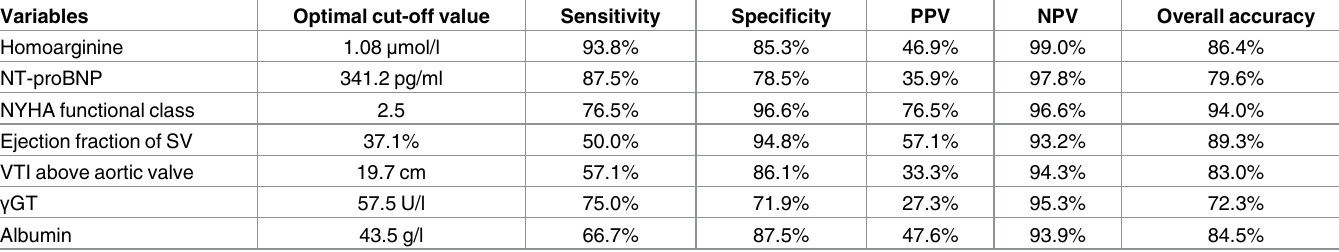
Table 3. Comparison of different parameters in predicting death due to progressive heart failure or the occurrence of overt heart